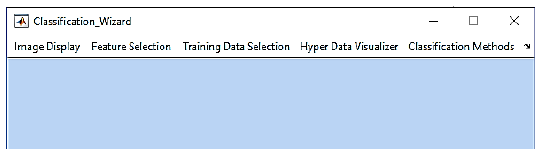
Figure 6. The interface of the classification module.